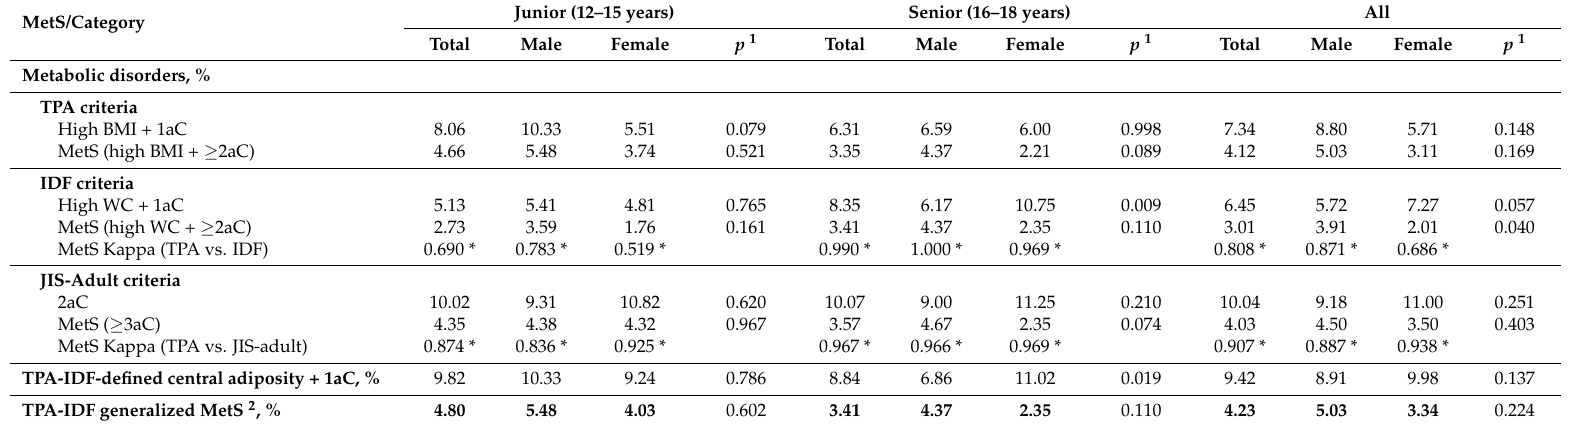
Table 3. Prevalence of MetS defined by TPA and IDF adolescent criteria and JIS-Adult criteria in adolescents, Taiwan.